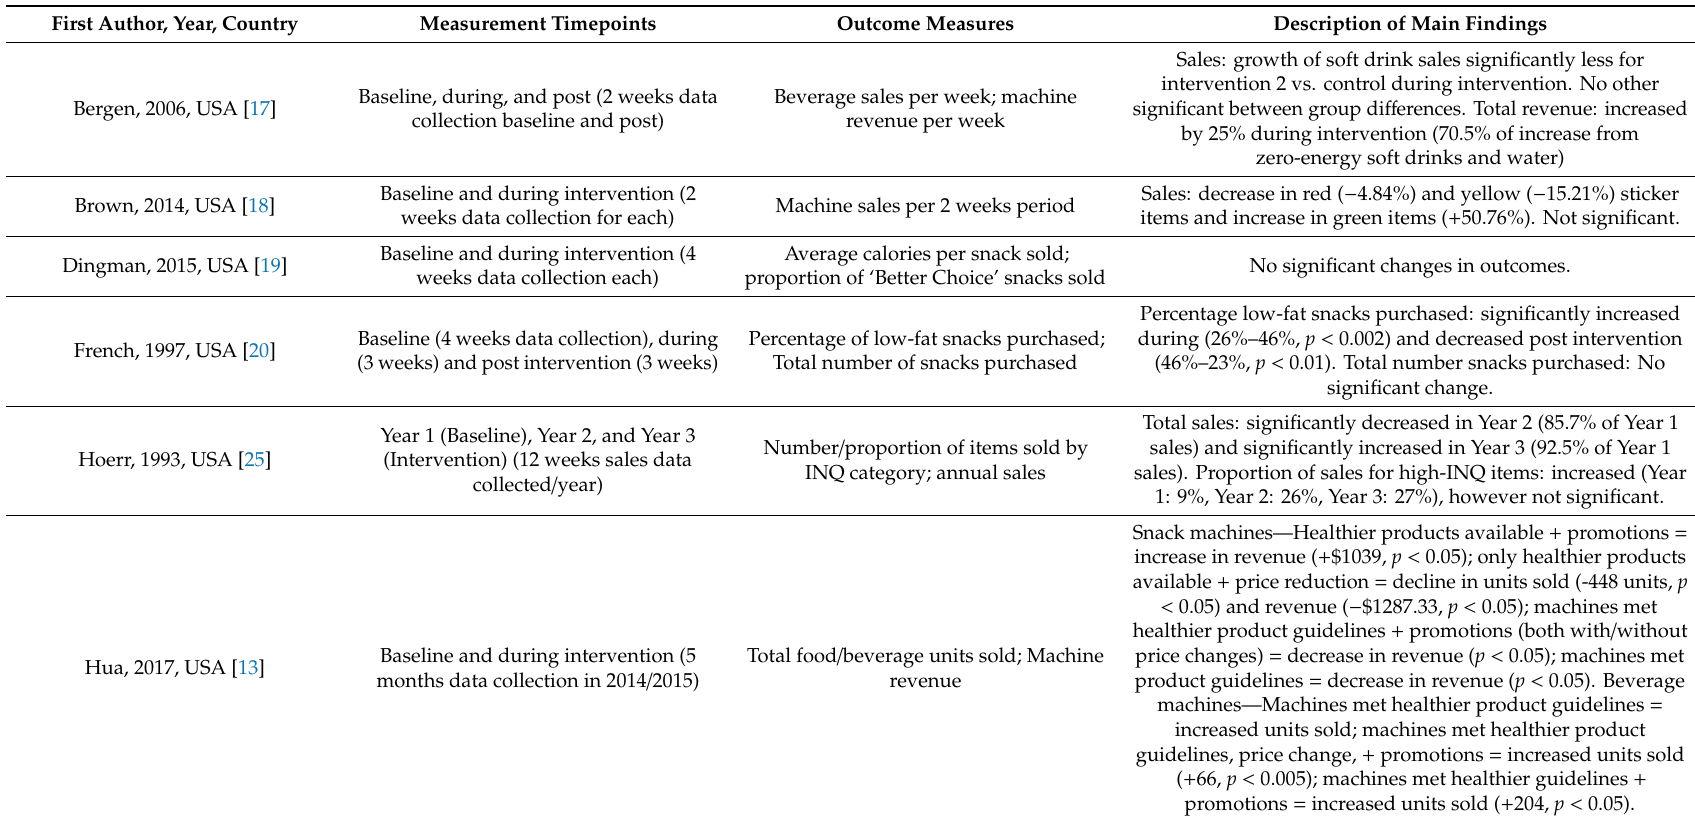
Table 2. Nutrition interventions in vending machines in the university setting: study